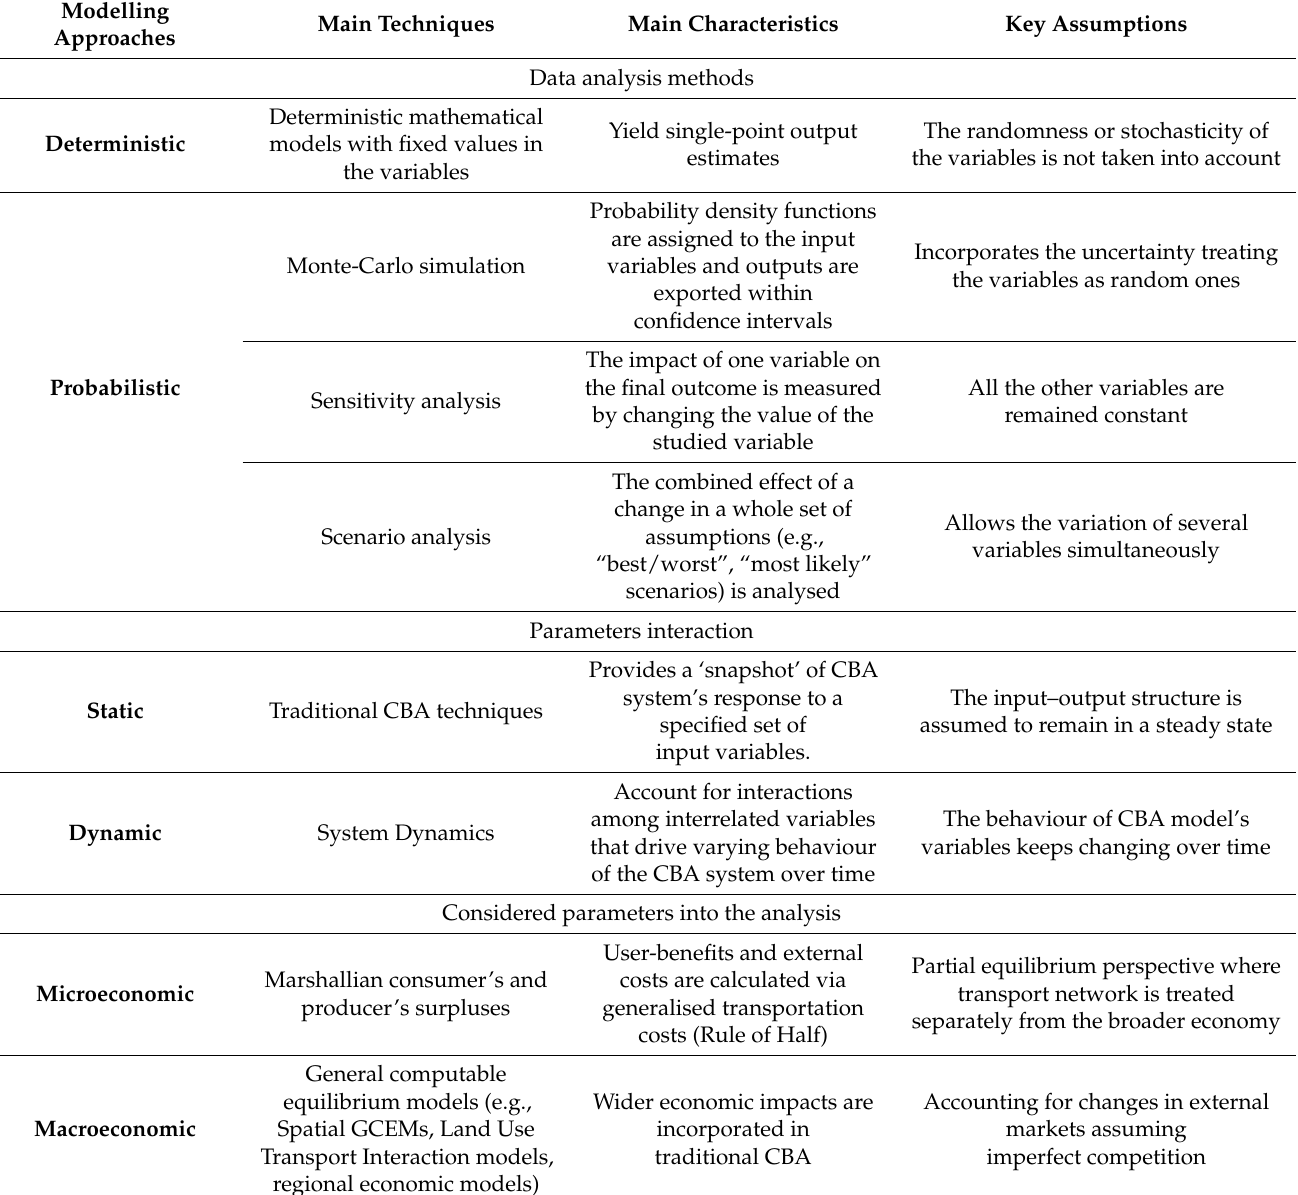
Table 1. Descriptive characteristics of modelling approaches found in the existing